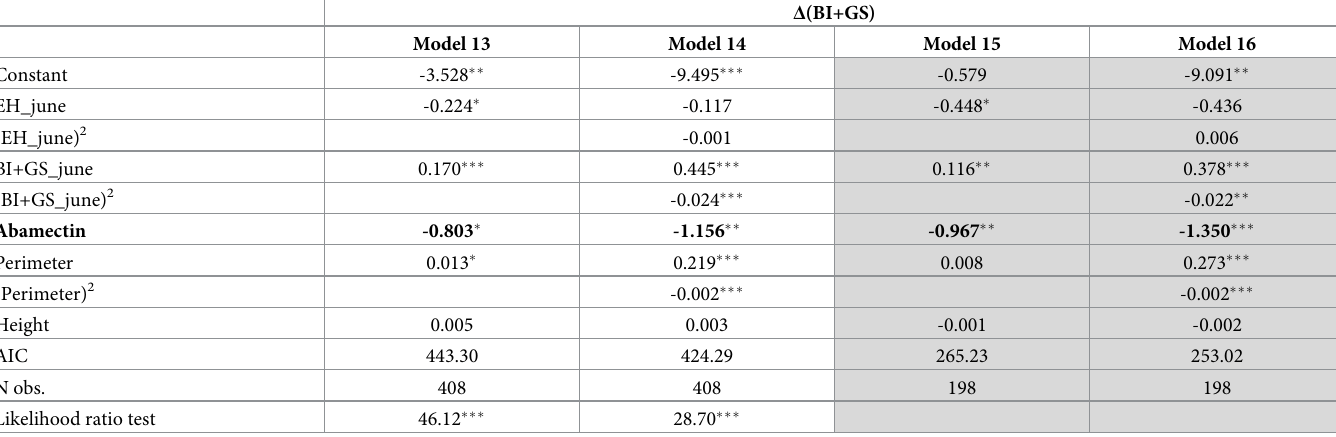
Table 5. Regression results with NBRM for BI and GS